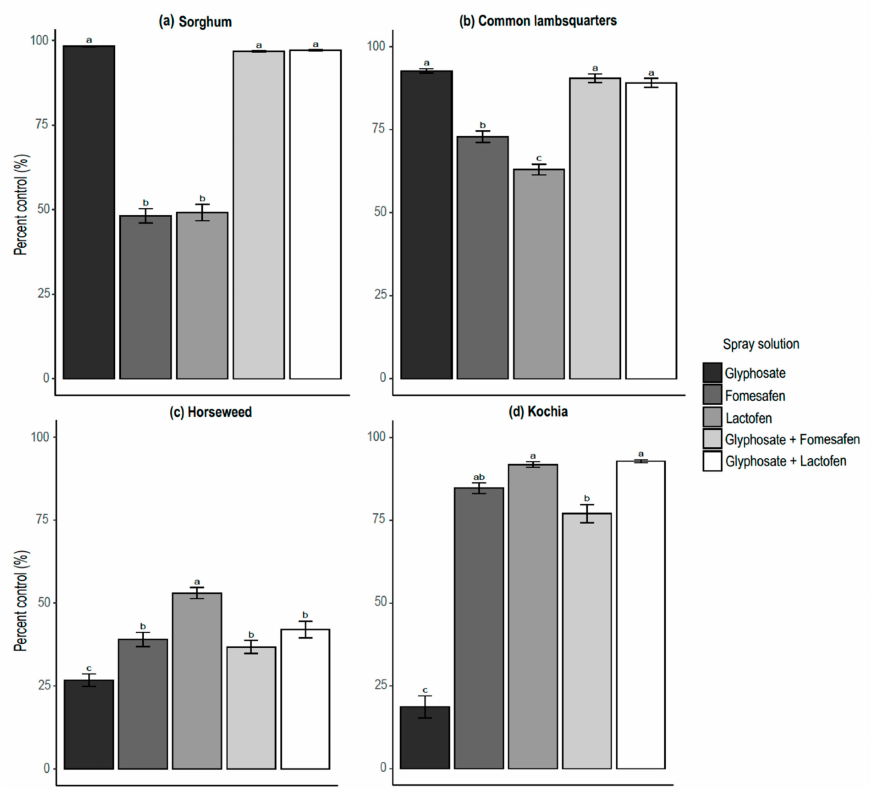
Figure 2. Percent of ( a ) sorghum, ( b ) common lambsquarters, ( c ) horseweed, and ( d ) kochia control based on dry biomass at 28 DAT treated with different herbicide tank-mixtures averaged across nozzle types evaluated from a greenhouse study conducted in 2016. Bars with same letter do not differ using Tukey post-hoc test at α =